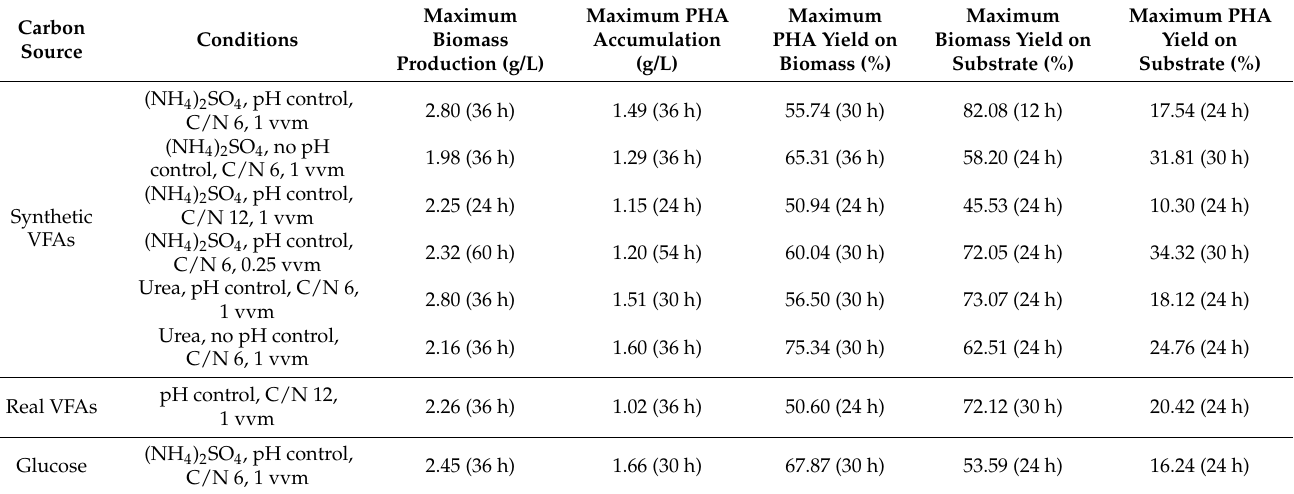
Table 2. Results of kinetic analysis of biomass production and polyhydroxyalkanoate (PHA) accumu- lation in different cultivation conditions.